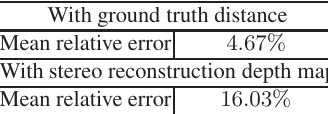
Table 2: Mean relative error between the estimated visibility dis- tance and the ground-truth value on 66 synthetic stereo images from Frida3 database. In the top part, the ground-truth depth- map is used and in the bottom part, the depth-map comes from the stereo reconstruction using Libelas